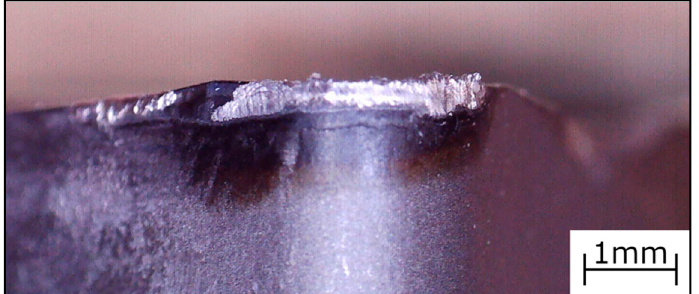
Figure 3. Microscope image of a representative cutting tool insert after reaching its end-of-life.